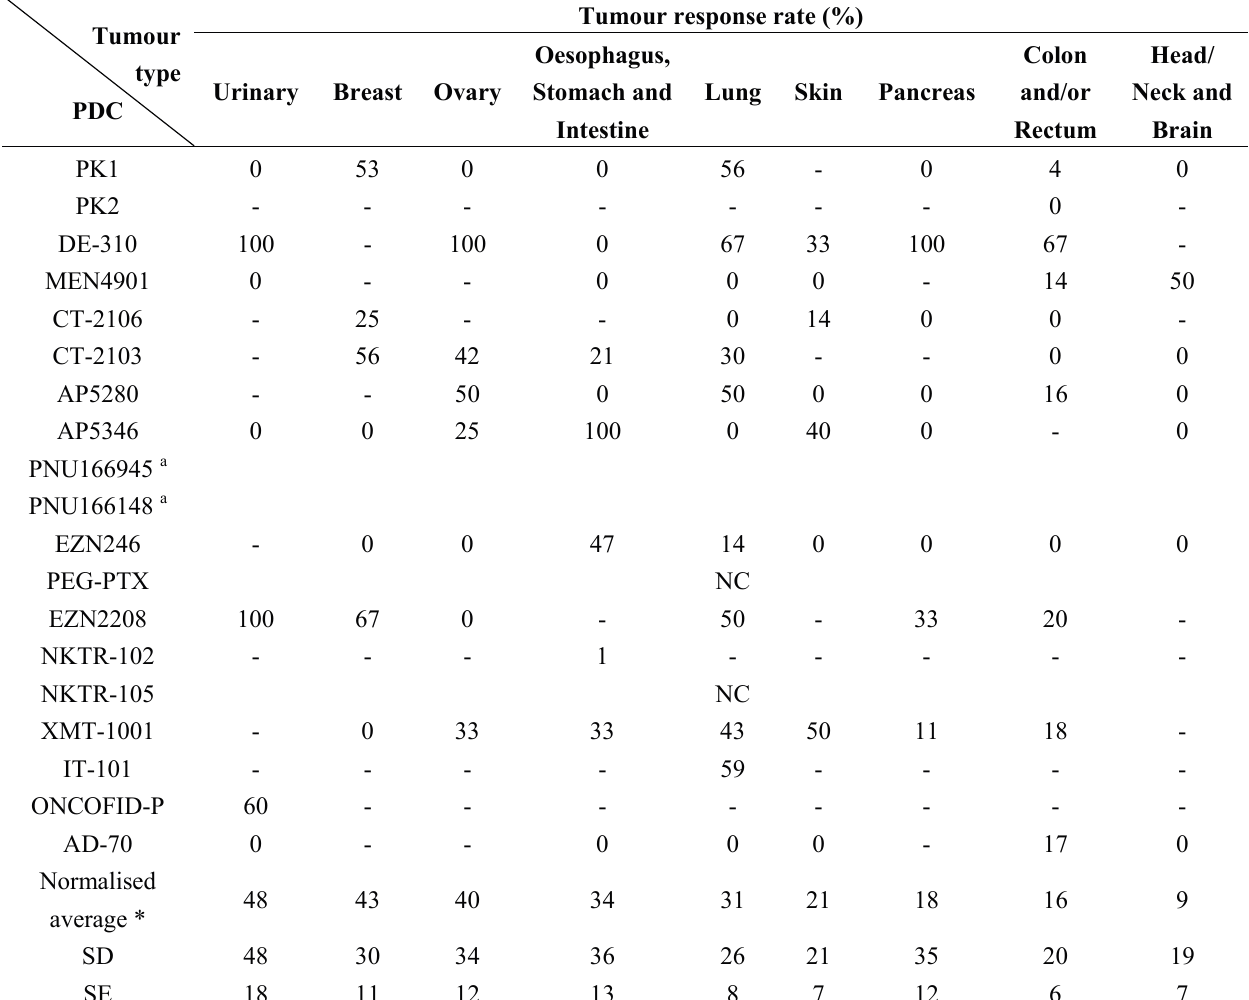
Table 5. Tumour response rates for PDCs (release mediated both by cathepsin and